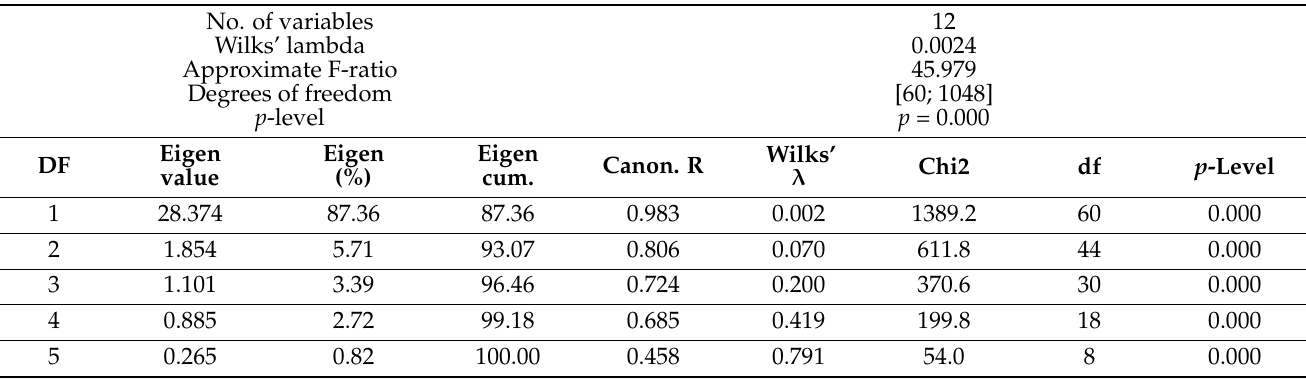
Table 2. Multivariate test regarding general significance of discrimination including tests of residual roots